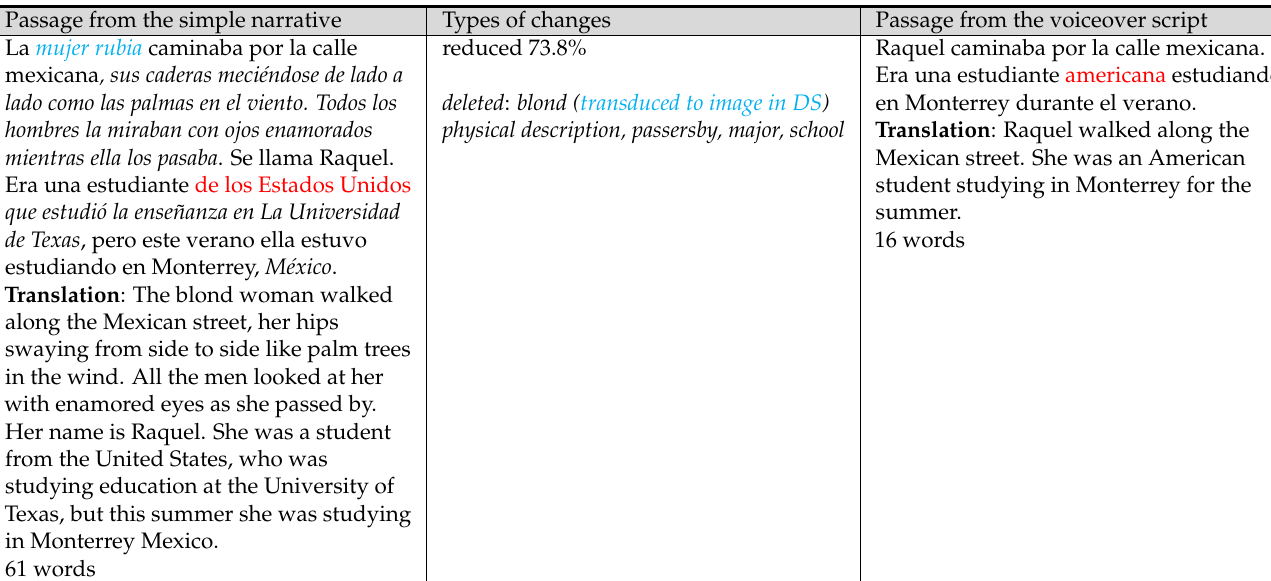
Table 2. Partial parallel-text table: Olivia’s individual DS